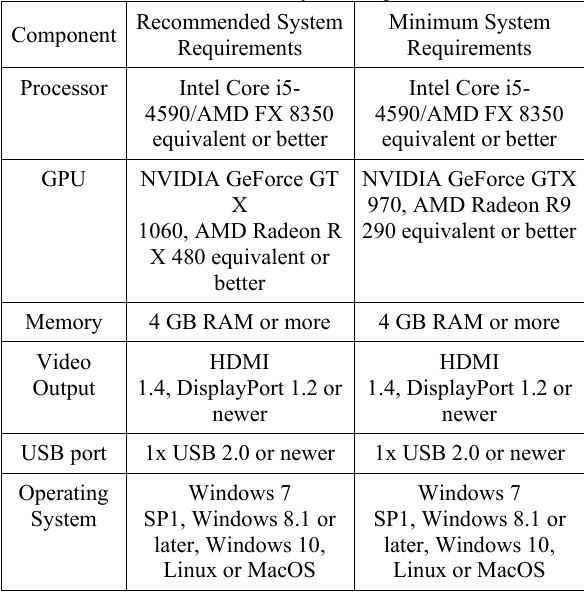
Table 1. HTC Vive ® system